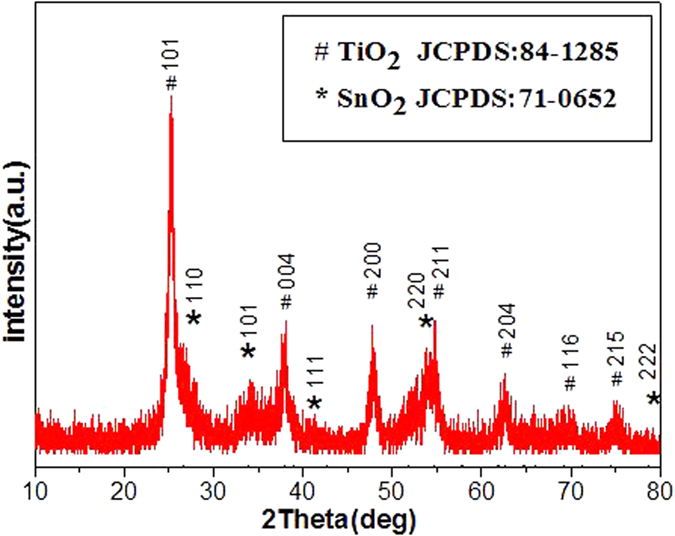
XRD pattern of hollow SnO2@TiO2 (a) and its precursor of SnO2 (b).